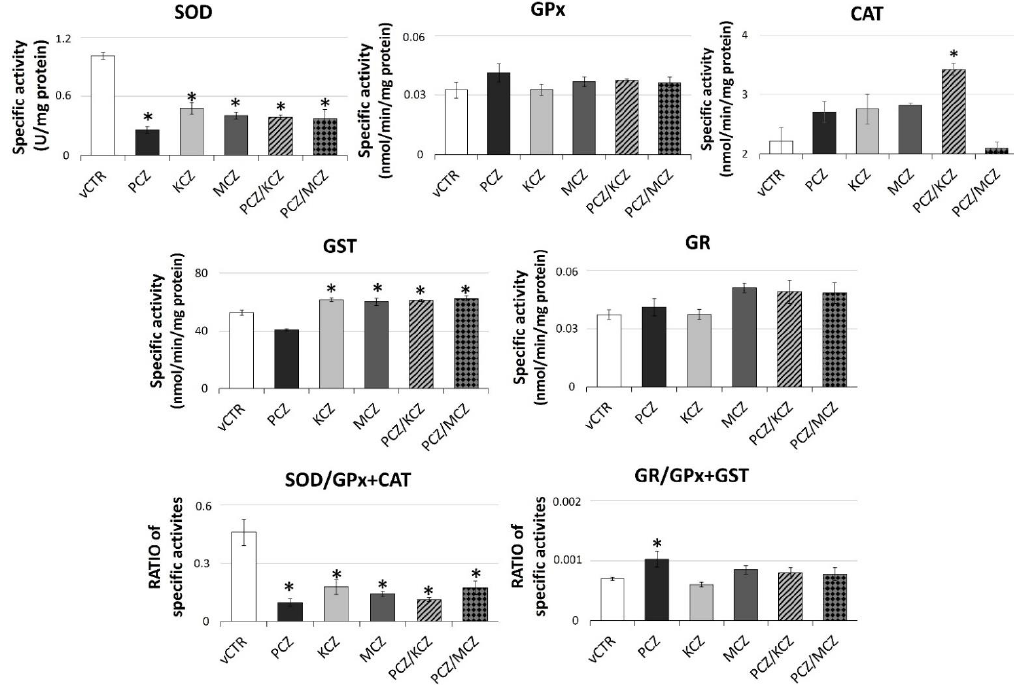
Figure 7. Azoles exposure significantly impairs SOD activity levels resulting in an altered SOD/GPx + CAT ratio. The specific enzymatic activities were assayed in samples incubated in the absence (vCTR) or in the presence of azoles after 3 h of exposure by spectrophotometric-based methods. Data are expressed as specific activities or ratios, as indicated, from three independent experiments and represent the mean ± SE; one-way ANOVA followed by Dunnett’s test or Holm–Sidak methods; * p < 0.05 vs.